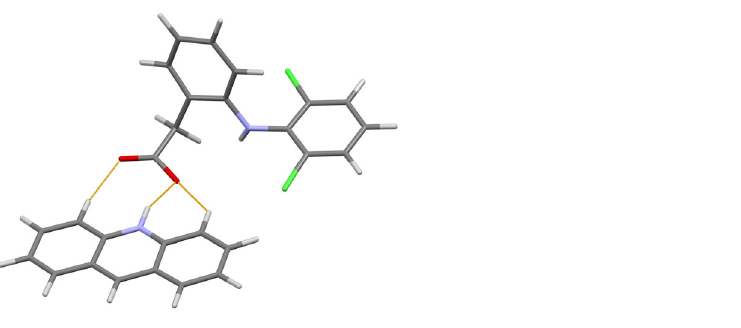
Figure 5. The content of asymmetric unit of the acridine diclofenac (1:1) salt. Thin orange lines denote intermolecular N–H…O and weak non-classical C–H…O hydrogen bonds.